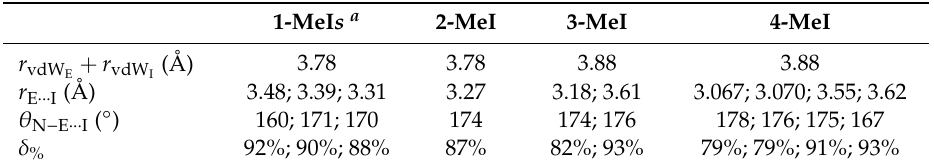
Table 3. Comparison of the sums of van der Waals radii, length ( d ), valence angles ( θ ) and parameters δ % of ChBs occurring in the crystal structures of the iodides (multiple values refer to two interactions di ff ering in